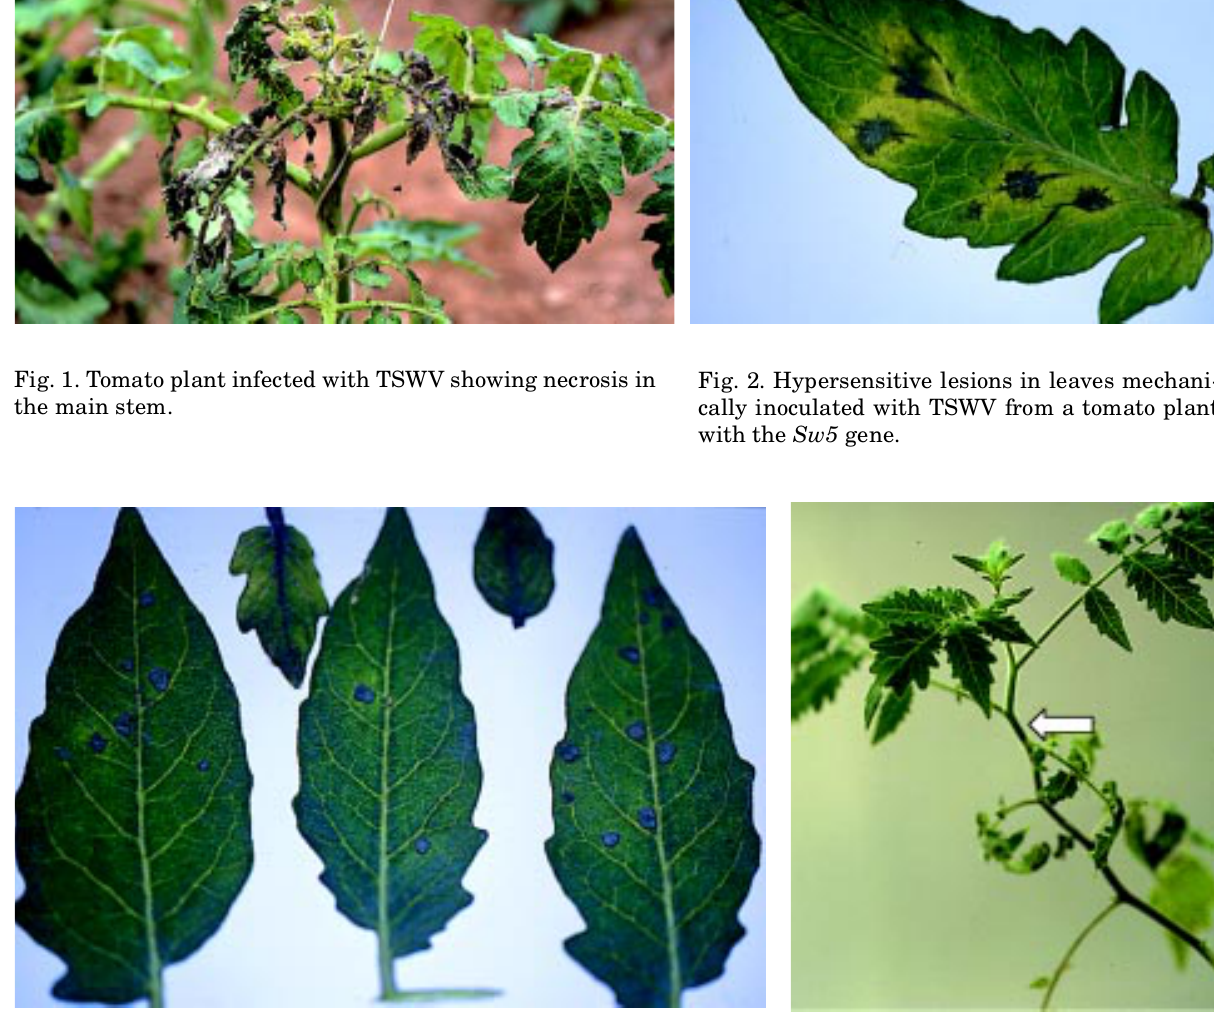
Fig. 4. Lycopersicon hirsutum plant with apparent recovery. The arrow indicates the transition zone between the infected and the recuperated